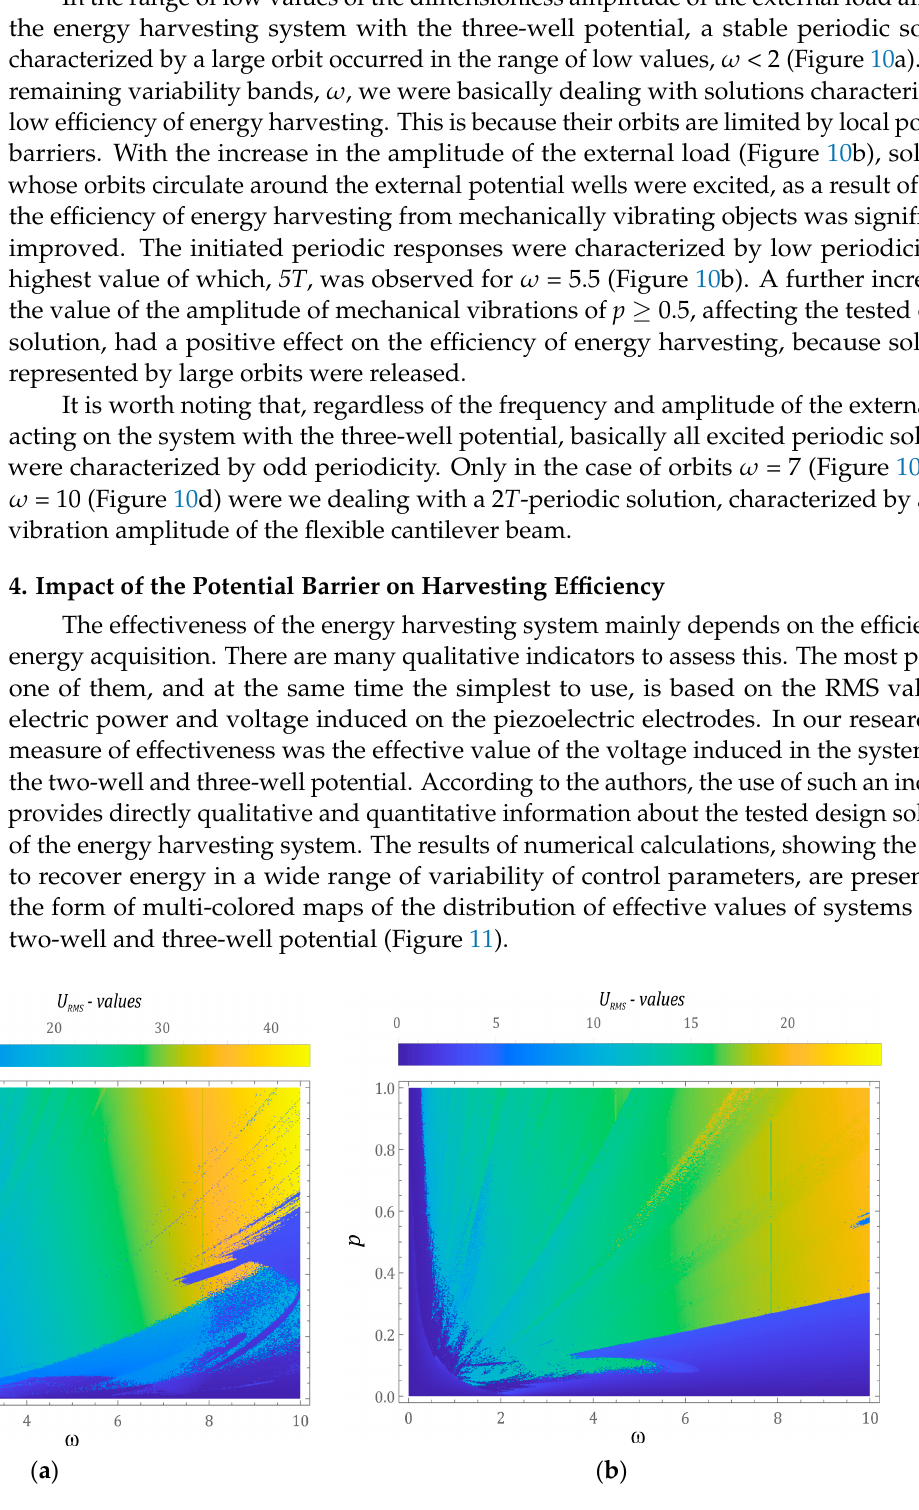
Figure 11. Multicolored maps of the values of effective energy harvesting systems (RMS voltage outputs) with the ( a ) two-well (BEH) and ( b ) three-well (TEH) potential for zero initial conditions. ω and p are dimensionless, while U RMS is expressed in Volts.